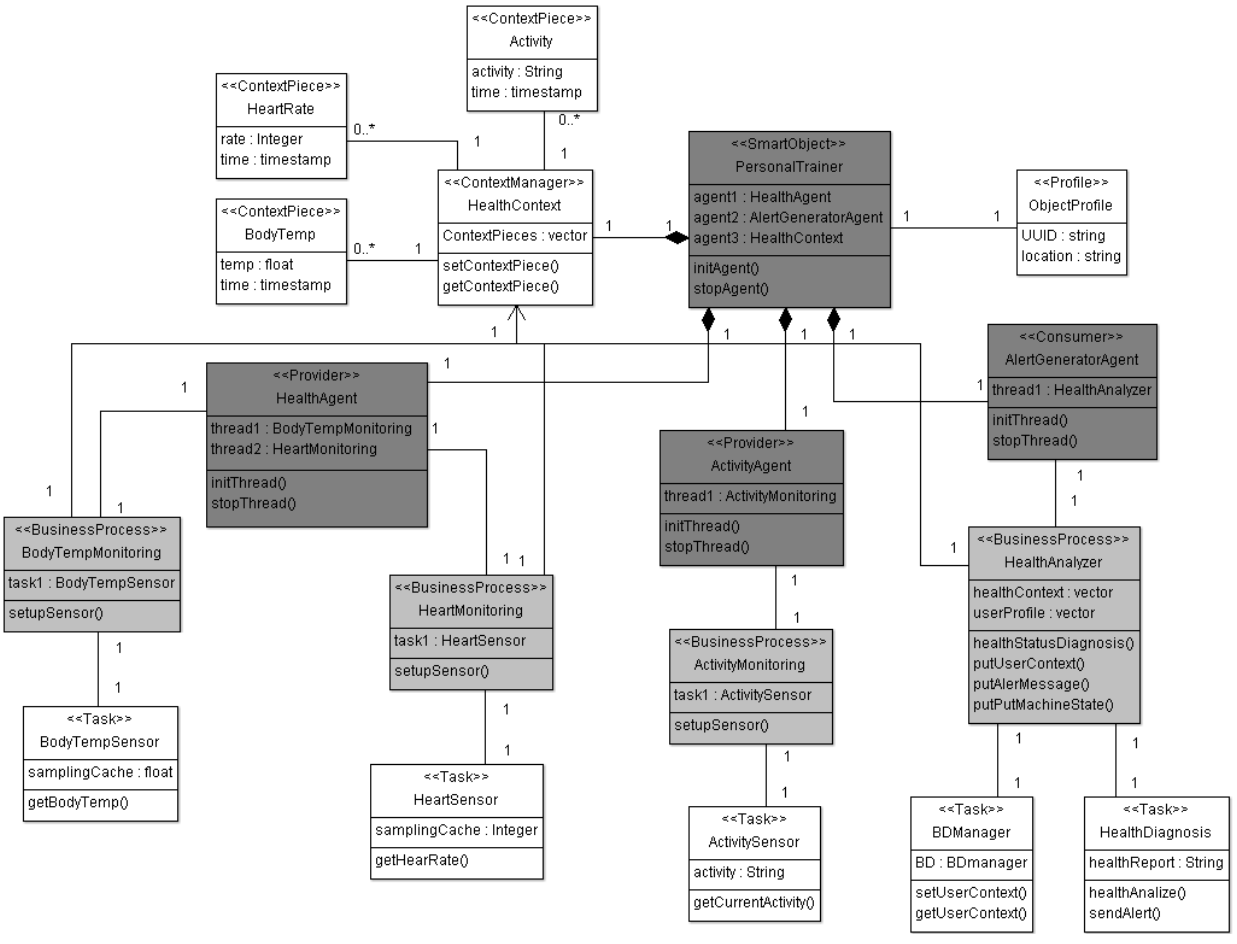
Figure 13. SOM model of the personal trainer belonging to the alert medical